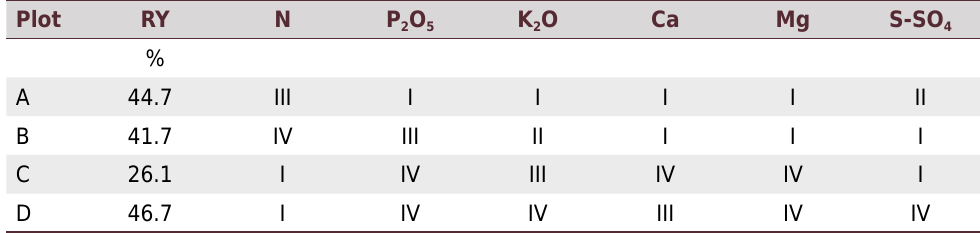
Table 6. Relative yield (RY) and classification of the plots per quadrant for the different nutrients, based on the criteria established by the Quadrant Diagram of the Plant-Soil Relationship (QDpsR) method